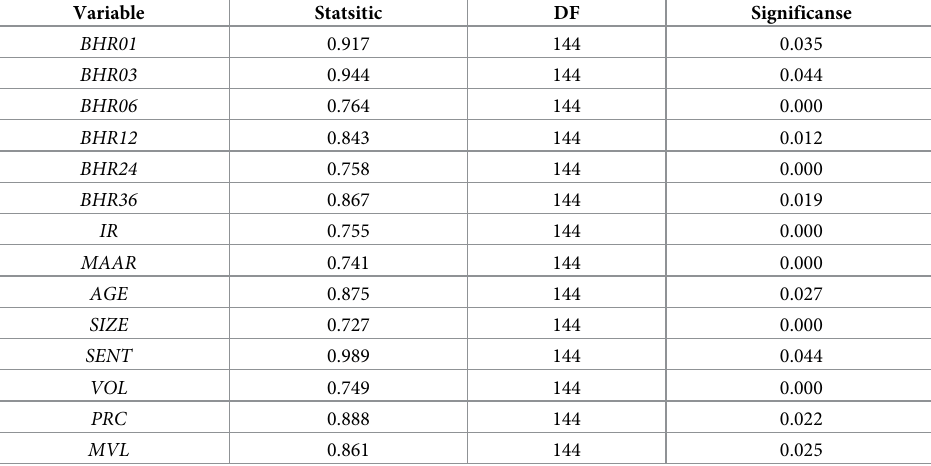
Table 6. Shapiro-wilk normality